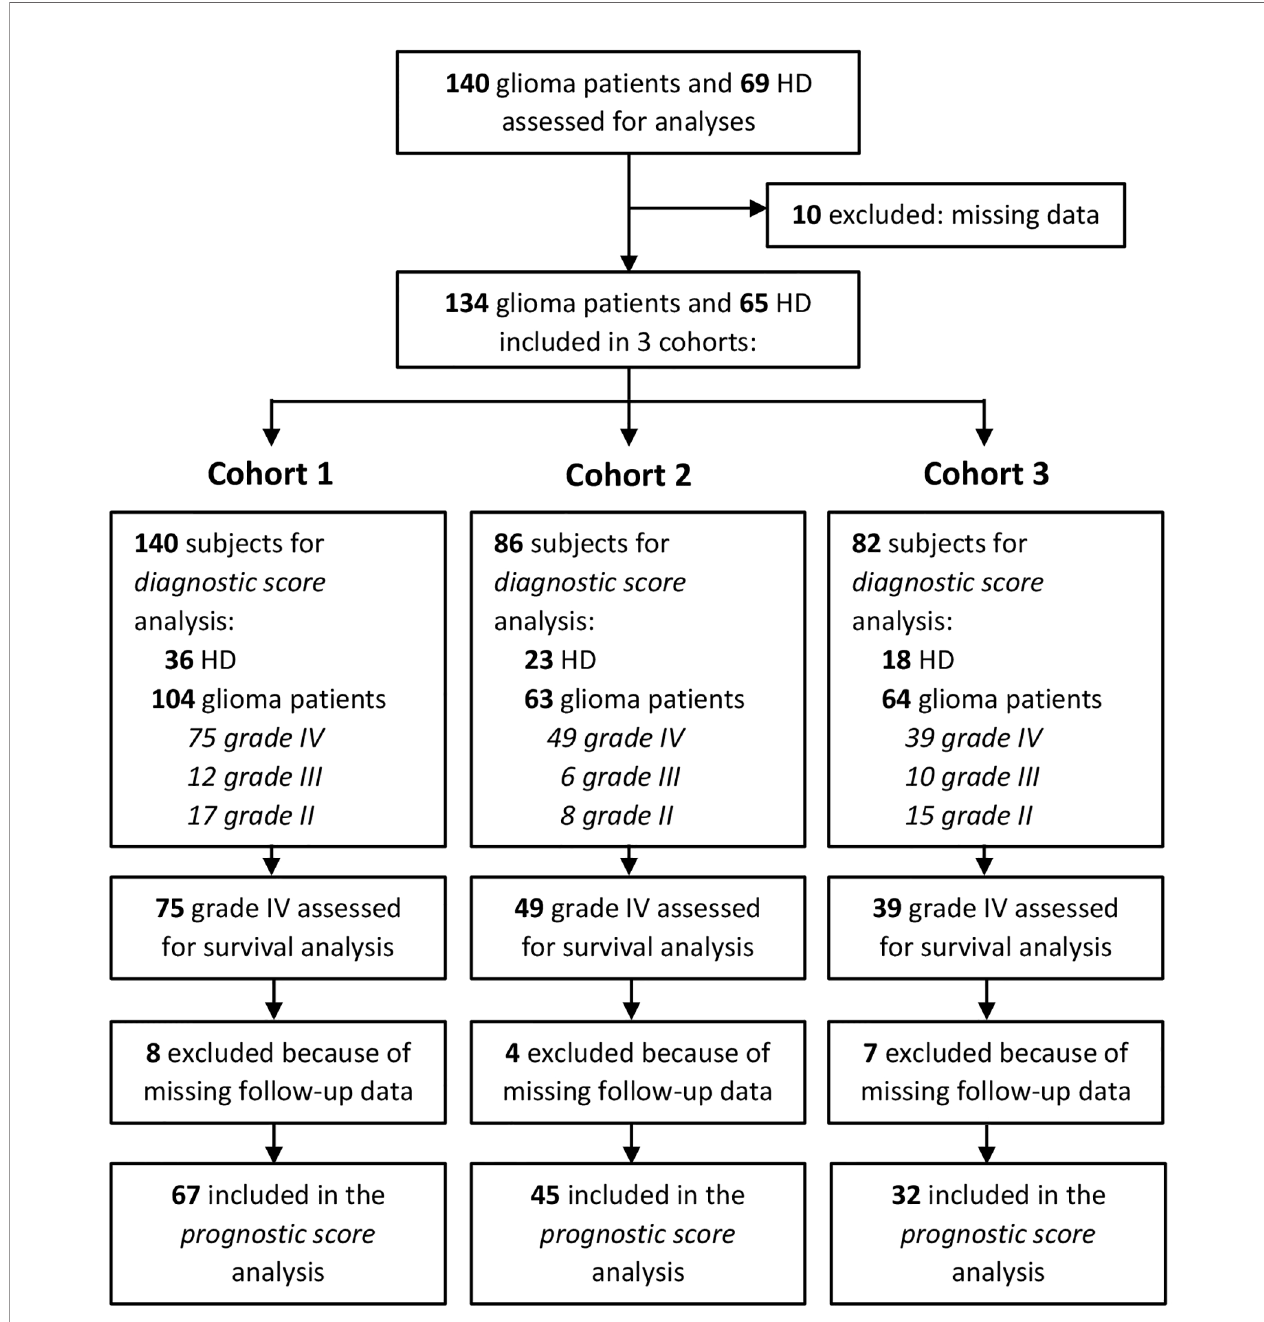
FIGURE 1 | Consort